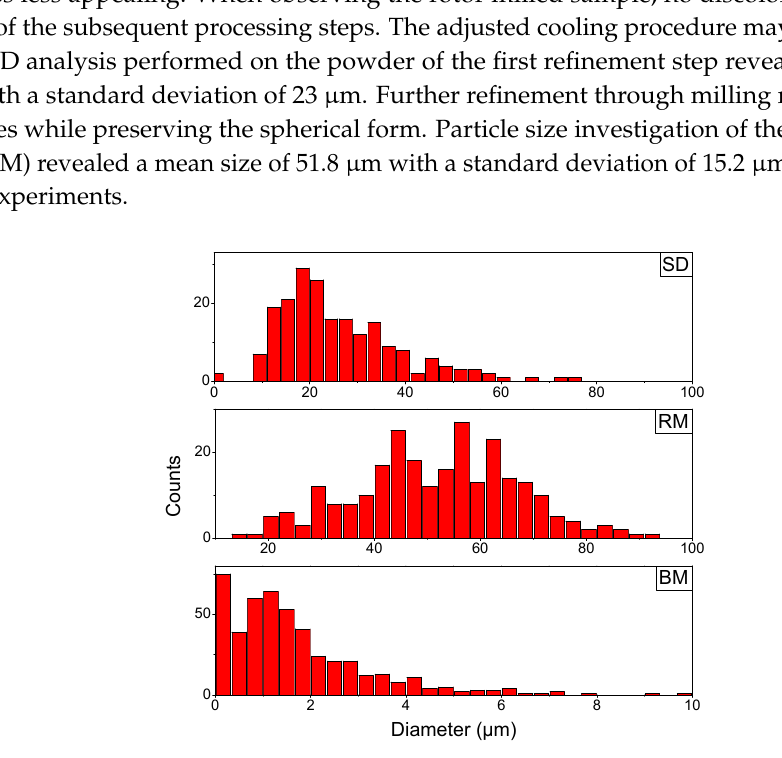
Table 2. Gel Permeation Chromatography (GPC) measurements of virgin and processed samples.